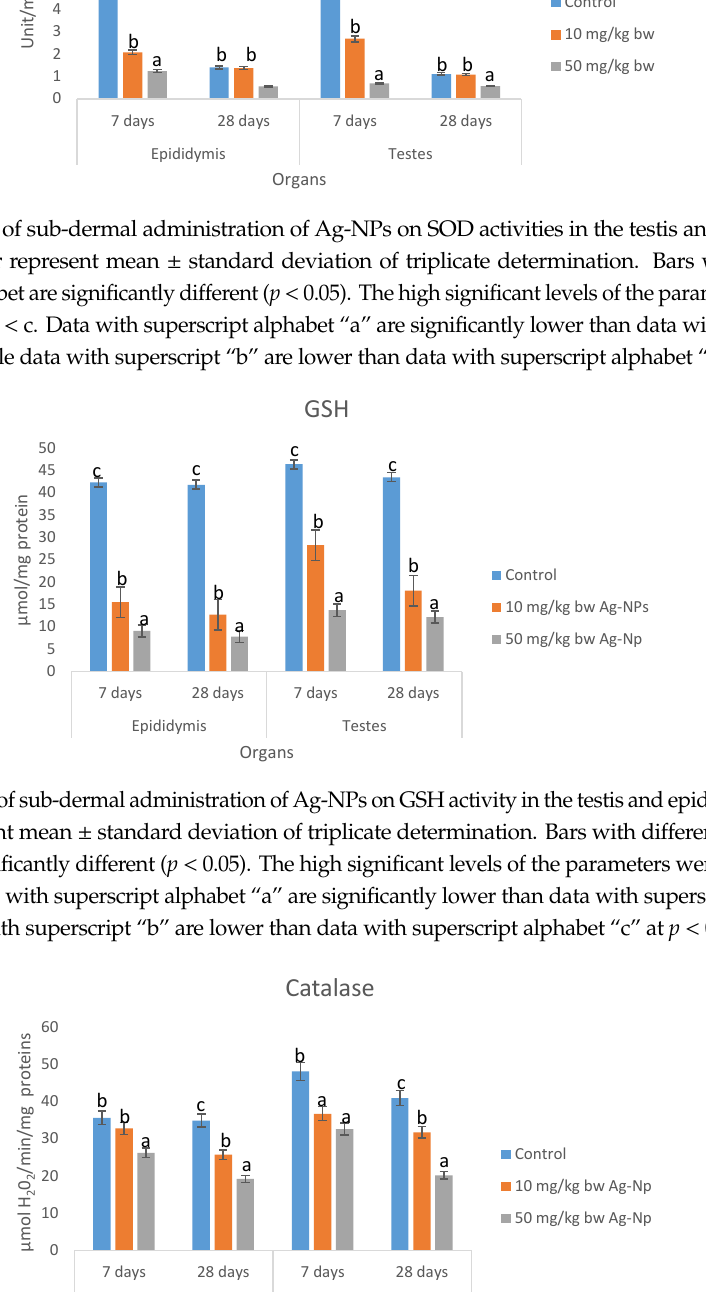
Figure 8: Photomicrograph of testes sections after exposure of rats to Ag-NPs showing; ( A ) several normal seminiferous tubules with normal spermatogonia cell, normal Sertoli cells, normal germ cell layer with normal maturation stages; ( B ) interstitial spaces show an area of interstitial congestion; ( C ) the lumen devoid of spermatozoa with interstitial congestion; ( D ) normal seminiferous tubules with normal spermatogonia cell, normal Sertoli cells, and normal germ cell layer; ( E ) maturation arrest of tubules and mild interstitial congestion; ( F ) seminiferous tubules with atrophy exhibiting thick double cell layers indicative of cessation of spermatogenesis. Magnification 400×. A: Control, B: 10 mg/kg bw,